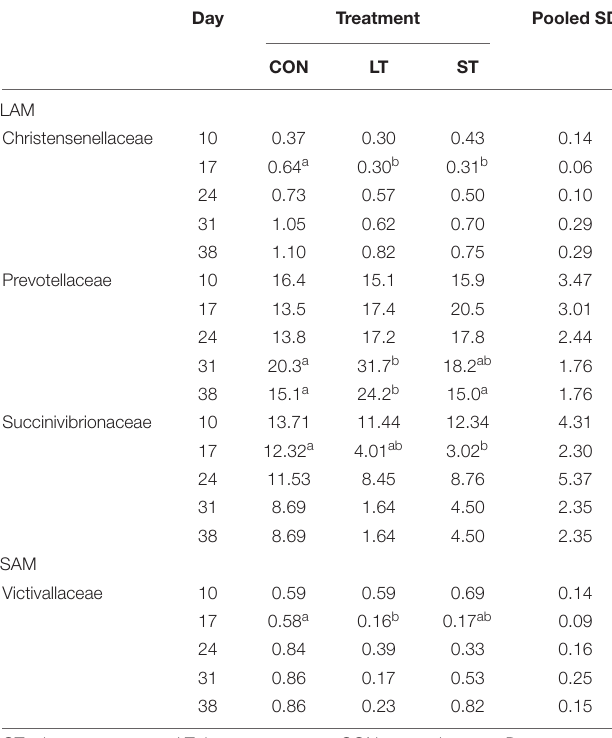
TABLE 3 | Differentially abundant bacterial families by treatment group in liquid- the day 17 CON samples as well as from the day 10 samples. At and solid-associated microbiota (LAM and SAM, respectively). day 24 and day 31, the LT and ST samples were widespread in the plot, whereas the two groups treated with Mootral moved closer Day Treatment Pooled SD to CON group at day 38 but remained more variable than the CON LT